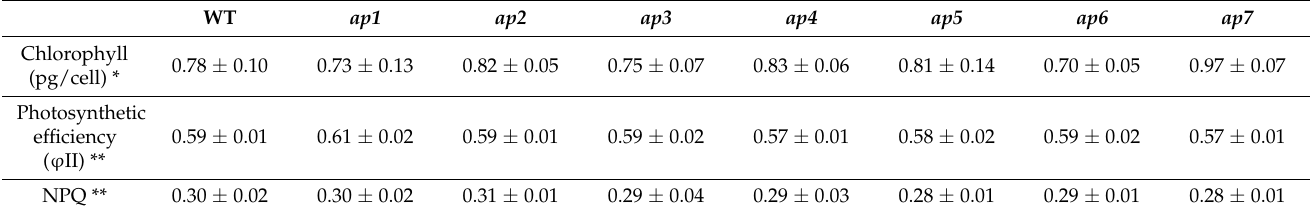
Table 2. Photosynthesis-related phenotypes of ap mutants.